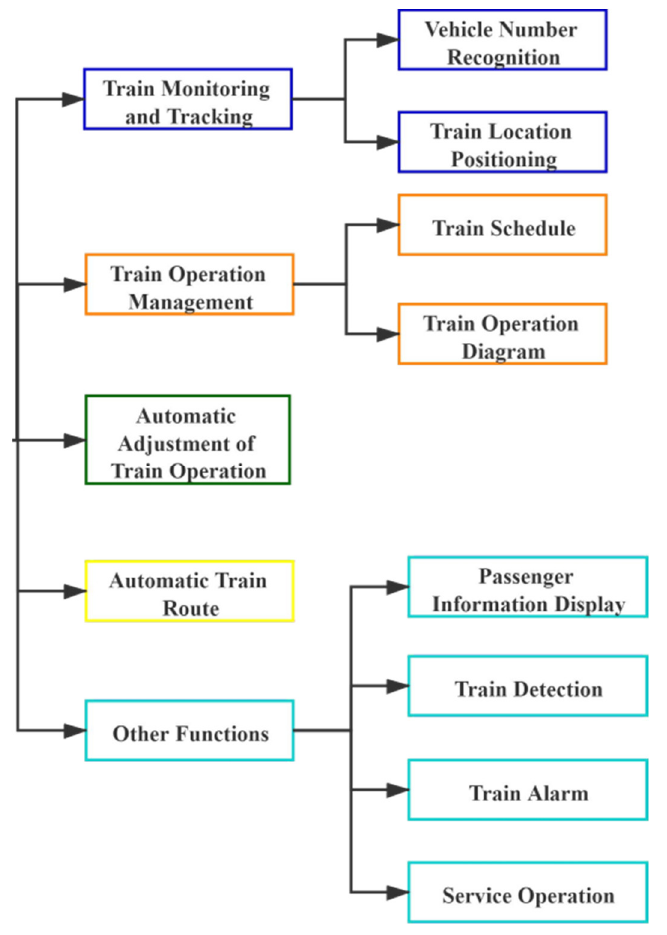
Figure 3. The functions of the ATS system.